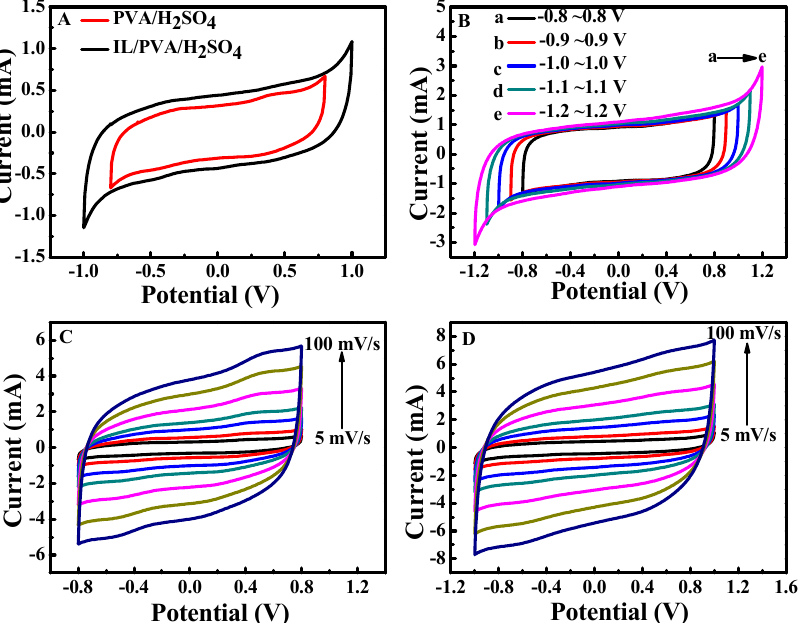
Figure 2. Cyclic voltammetry (CV) curves of solid-state polymer supercapacitor (SSC) based on different gel polymer electrolyte (GPE) at 5 mV/s ( A ), SSC-IL/PVA/H 2 SO 4 at 20 mV/s within different electrochemical windows ( B ), SSC-PVA/H 2 SO 4 ( C ) and SSC-IL/PVA/H 2 SO 4 ( D ) at different scan rates.